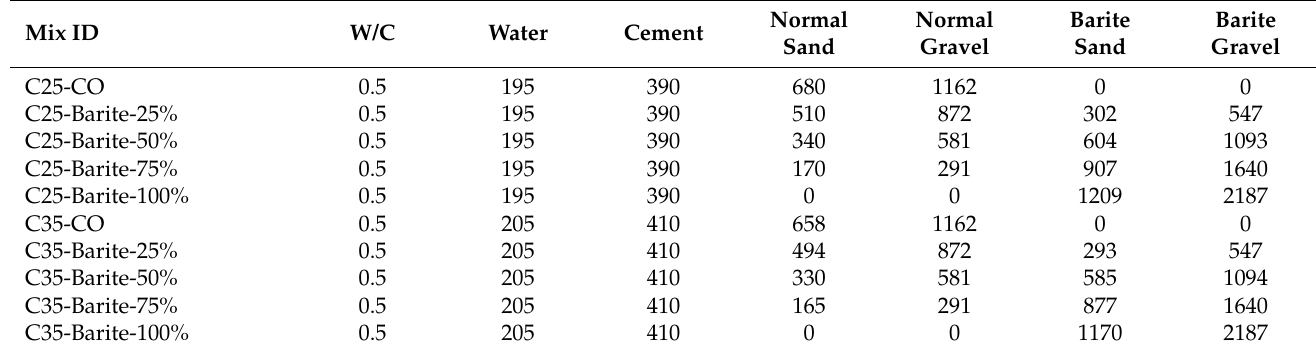
Table 4. Mixture proportions of concrete (kg/m 3 ).